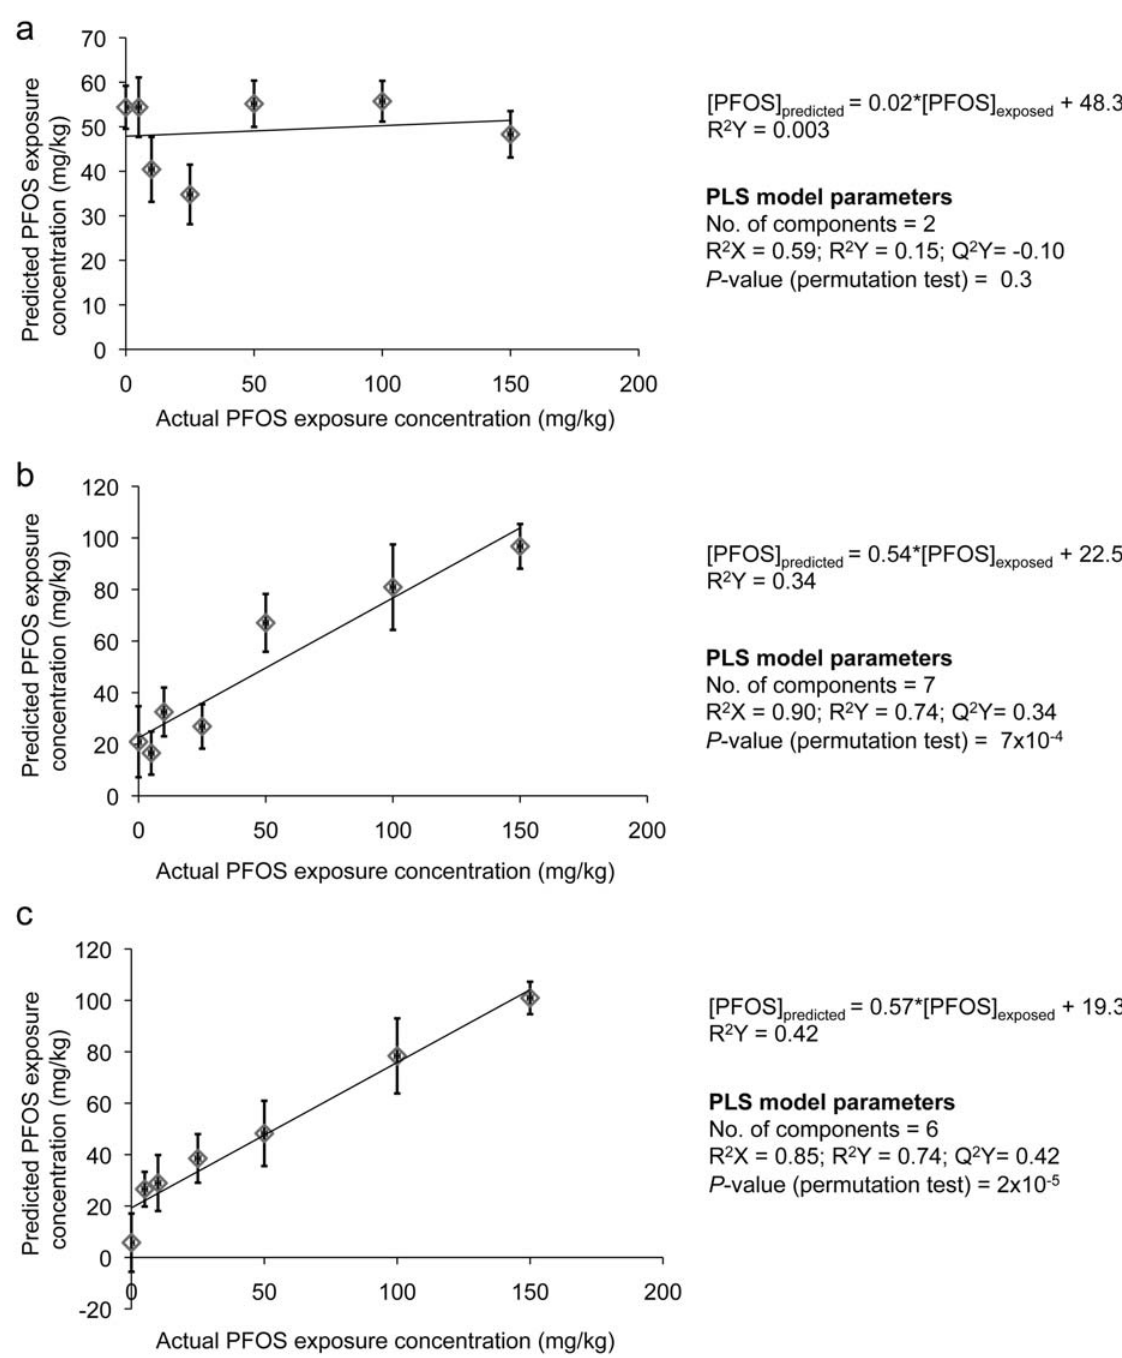
Figure 3. Average predictions of PFOS concentrations ( ŷ ), given spectra i by the PLS i model derived from the leave-one-out cross-validation procedure with spectra i omitted for PLS models constructed with the bucketed 1 H NMR spectra as the X-table and the PFOS exposure concentrations as the Y variable. The solid line indicates a linear regression between the actual and predicted values. The PLS-regression models correspond to ( a ) two days of exposure, ( b ) seven days of exposure and ( c ) fourteen days of exposure. The error bars represent the standard error of the